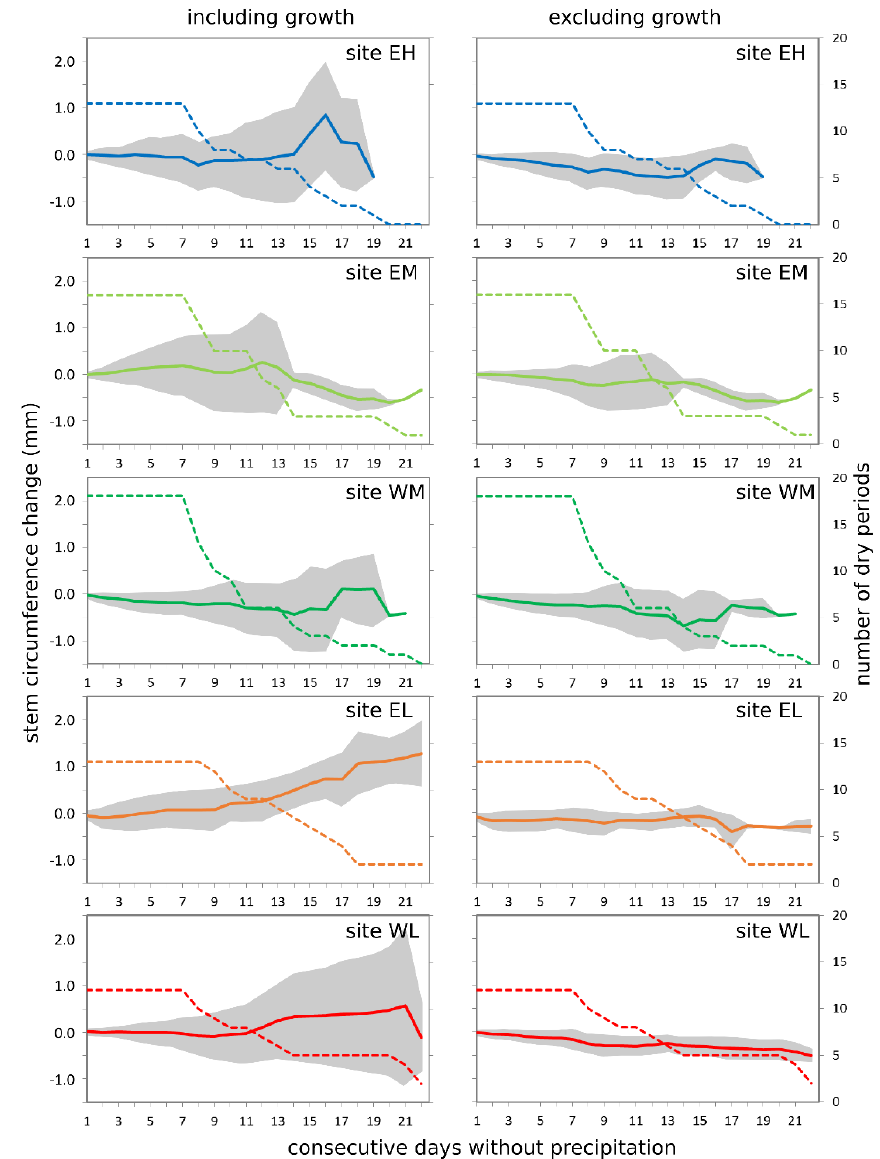
Figure 7. Mean stem circumference changes (solid lines; grey shaded areas indicate the range expressed as mean ± 1 standard deviation) during dry periods of at least seven consecutive days without precipitation including ( left column ) and excluding ( right column ) tree growth. Dashed lines indicate the number of dry periods. Dry periods are extracted from the time period May 2017 to April 2019. Site codes refer to the east (E) and west (W) sides of Corsica, L, M, and H stand for low-, middle-, and high-elevation sites, respectively.